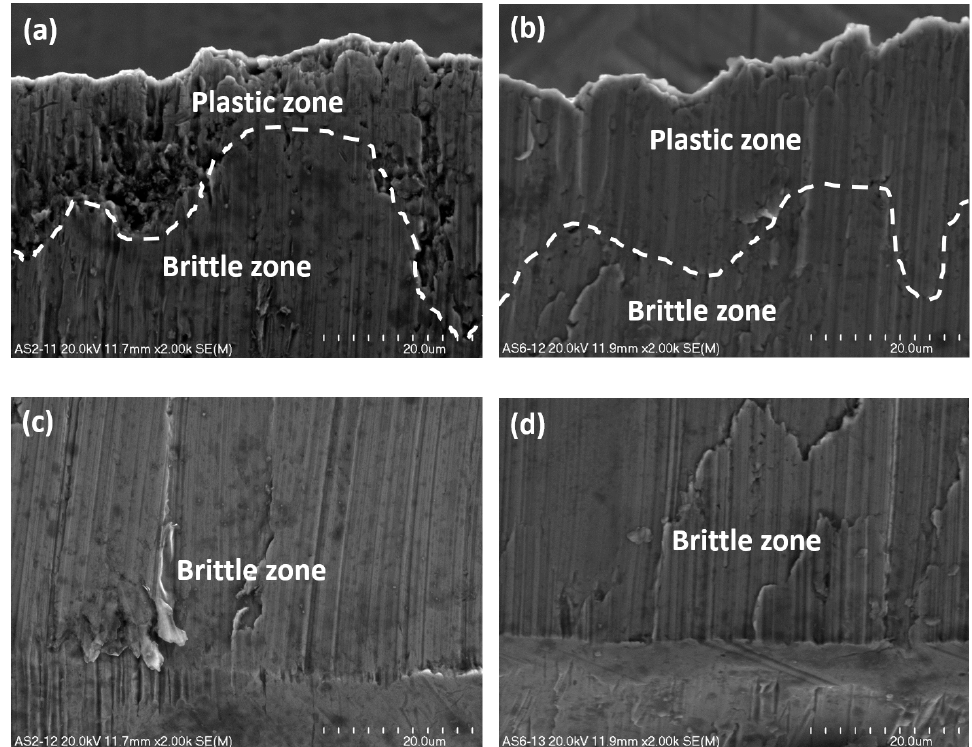
Figure 8. The upper part ( a , b ) and the lower part ( c , d ) of a surface of the bottom sheet in a bundle zoomed in × 2000; view from the front ( a , c ) and from the rear of a knife ( b , d ). Comparing the ductile zone in both sheets viewed from the front and back of the cutting tool, it can be stated that both are deformed plastically with many various defects due to shearing, although those regions located in the front of the knife are more corrupted (Figures 7a and 8a). On these surfaces, many dimples characteristic for plastic damages are visible, while in those surfaces seen from the rear of the knife, the dimples have not been detected (Figures 7b and 8b). Comparing the brittle zone viewed from the front (Figures 7c and 8c) and back (Figures 7d and 8d) of the cutting tool, it can be affirmed that in both sheets, the surfaces are flat and smooth practically without defects; however, there are some minor differences in terms of the top and bottom sheet in a bundle. Taking into account the first sheet, there are no evident detected differences between the front (Figure 7c) and the back of the knife (Figure 7d). Considering the second sheet, the surfaces viewed from the front of the cutting tool are less defected because a smaller number of brittle walls is present (Figure 8c) with the respect to the surfaces viewed from the rear of the cutting tool (Figure 8d). In the present paper, only two sheets have been considered using a symmetrical knife. The morphological features of the cross-sections are similar to those investigated by Kaczmarczyk et al. [17] concerning the cutting of a bundle comprising two sheets with a non-symmetrical knife. The size of the plastic and brittle fracture constitutes the main distinction; in the case of a symmetrical blade of a knife, the size of the plastic area is substantially smaller than in the variant of the cutting process by means of a non-symmetrical knife. 3.4. Comparison of the Numerical and Experimental Investigations